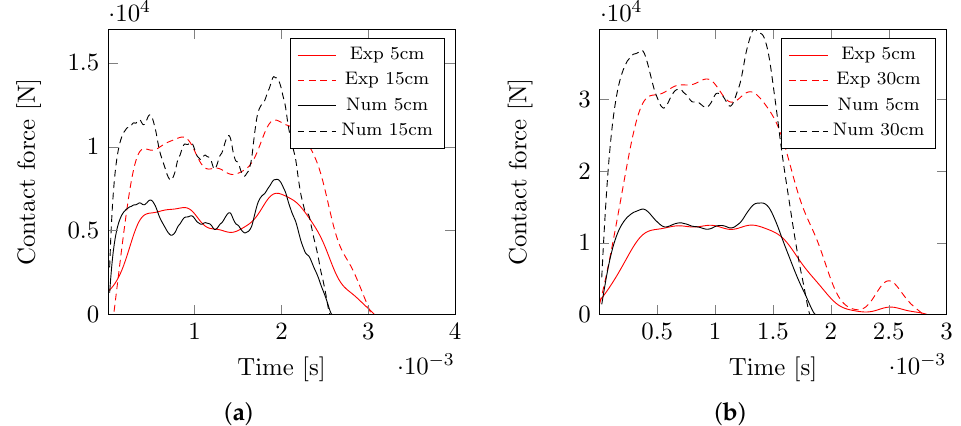
Figure 12. Comparison of evolution of measured and predicted contact force for nondestructive test: ( a ) 5LG-3 laminate; ( b ) 7LG-2